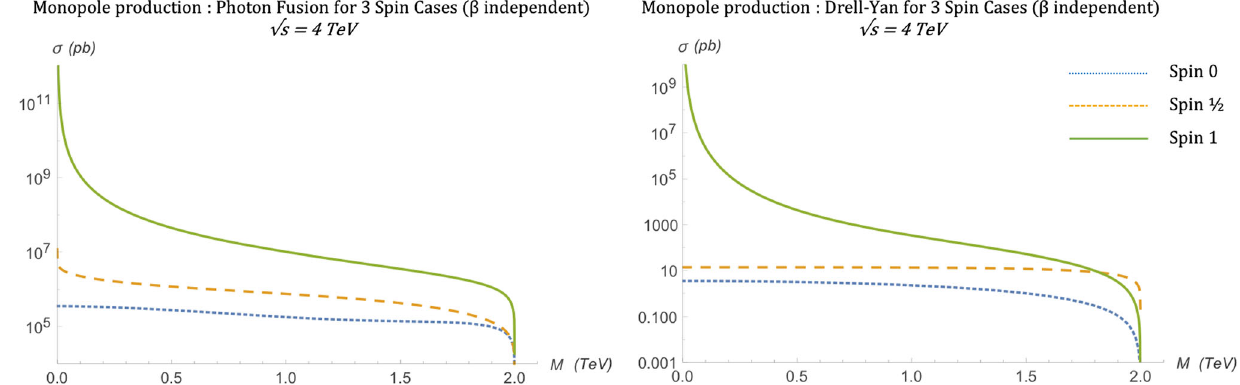
Fig. 21 Comparison of the cross section between all three spin models √ s qq /γγ = 4 TeV varying with monopole mass M for PF (left) and at DY (right) and for β -independent coupling. In the S = 1 / 2 and S = 1